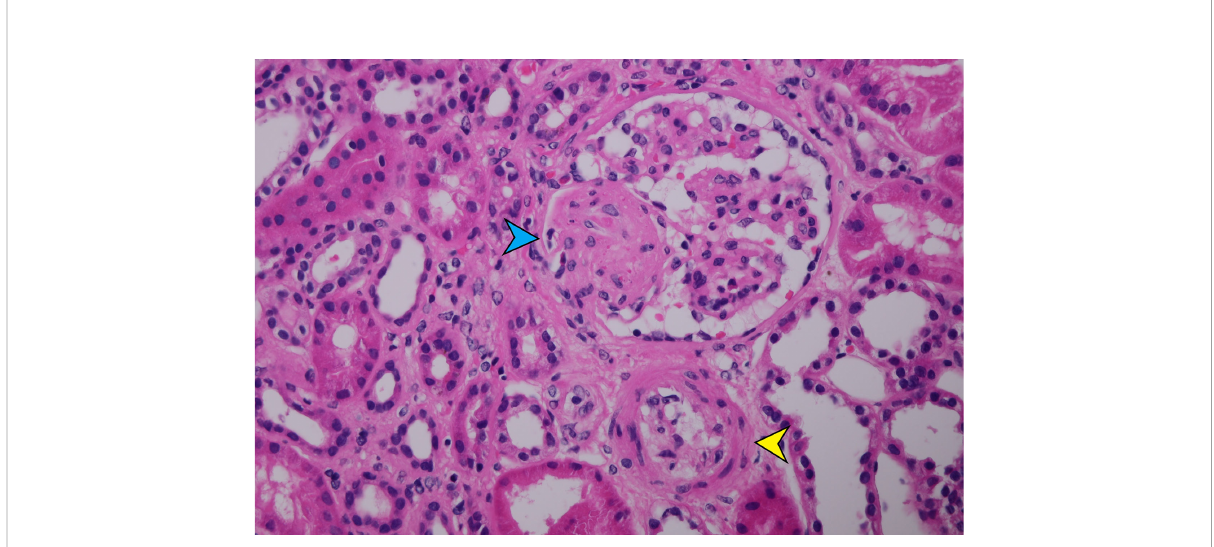
FIGURE 1 Segmental microthrombosis and mesangiolysis with entrapped erythrocytes (blue arrow) and arteriole with narrowed lumen due to marked intimal edema (yellow arrow)